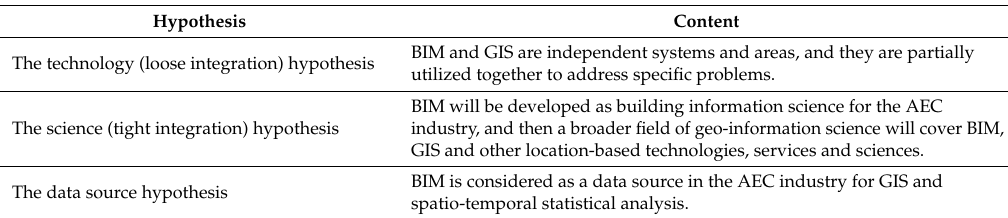
Table 5. Contents of three hypotheses of future trends of BIM-GIS